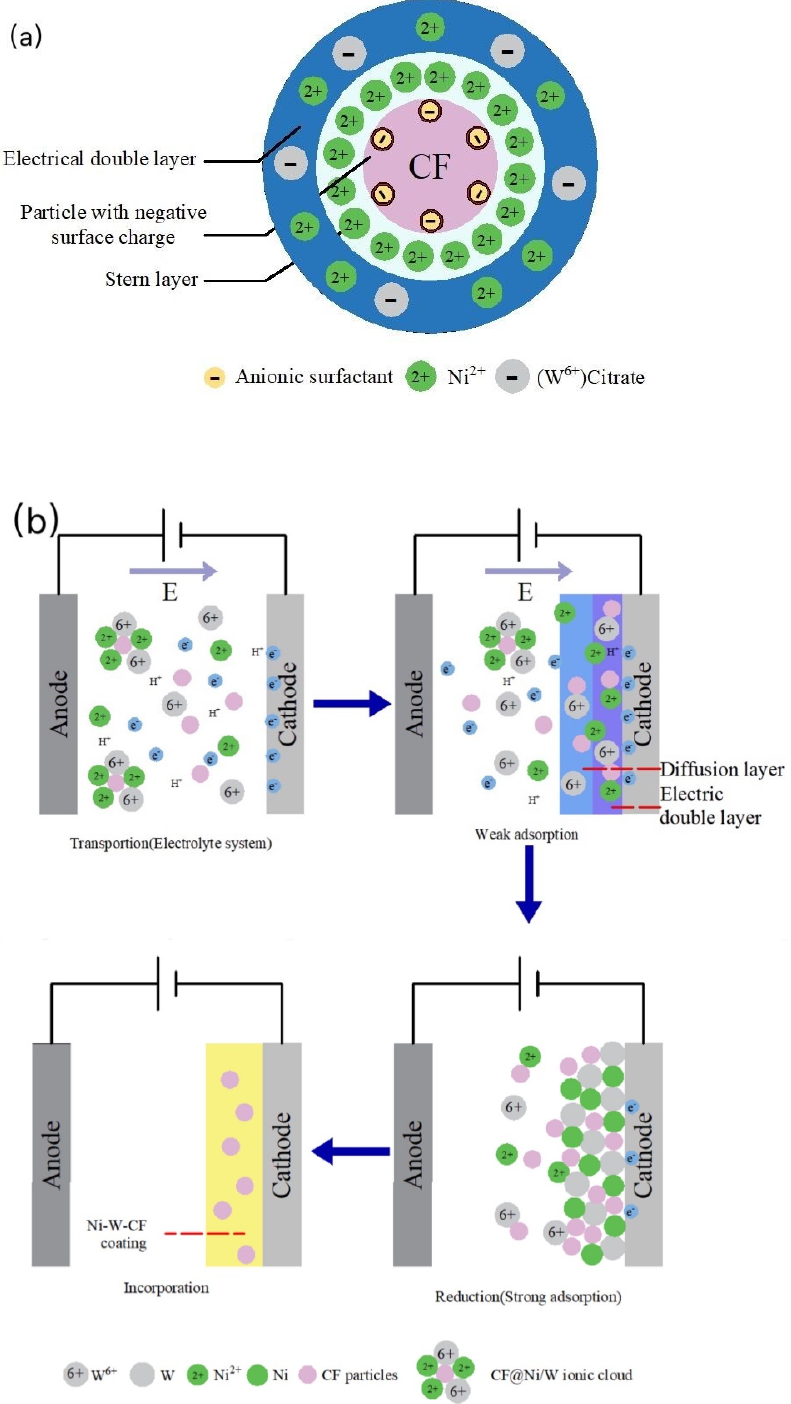
Figure 9. Schematic diagram of ( a ) charge distribution around the CF particle; ( b ) Co-deposition process of Ni-W-CF composite